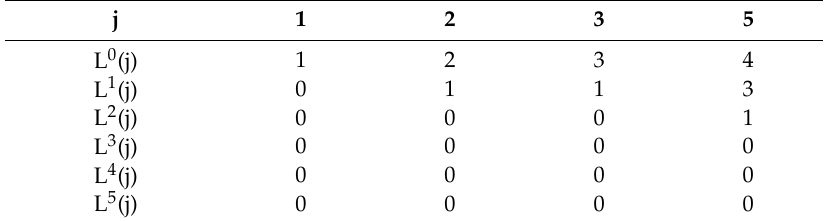
Table 1. Grinding machine multi-body system low sequence body array.